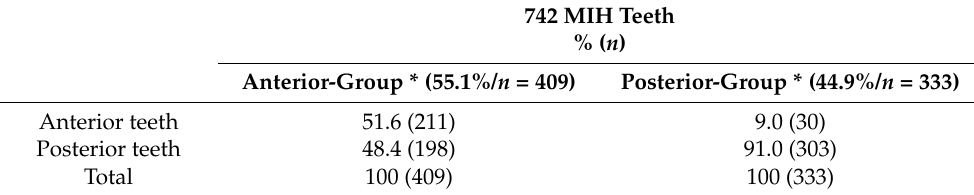
Table A2. Summary of tooth related data on 742 MIH teeth with regard to localisation.